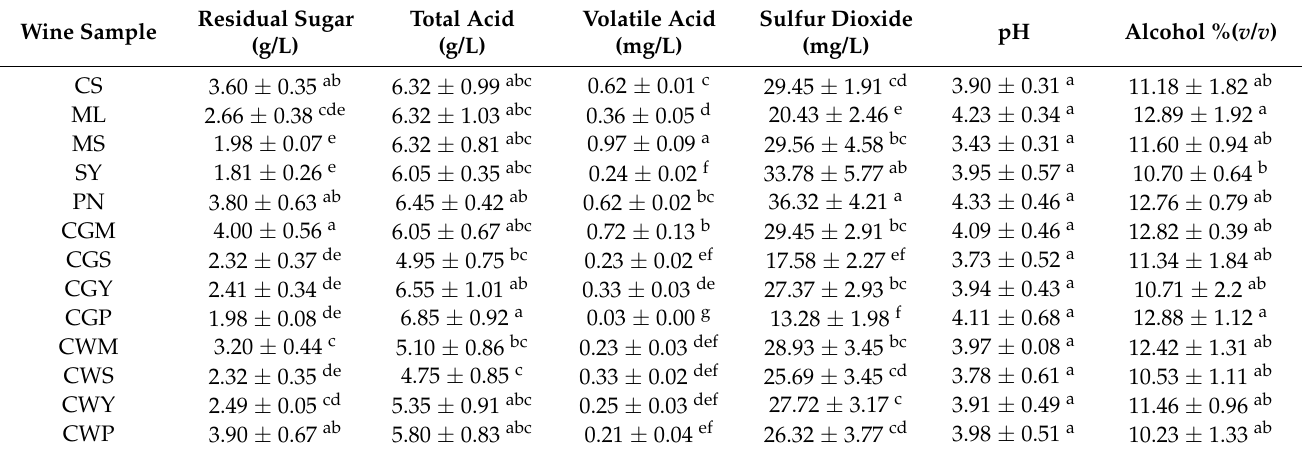
Table 1. Physicochemical indexes of wine sample.